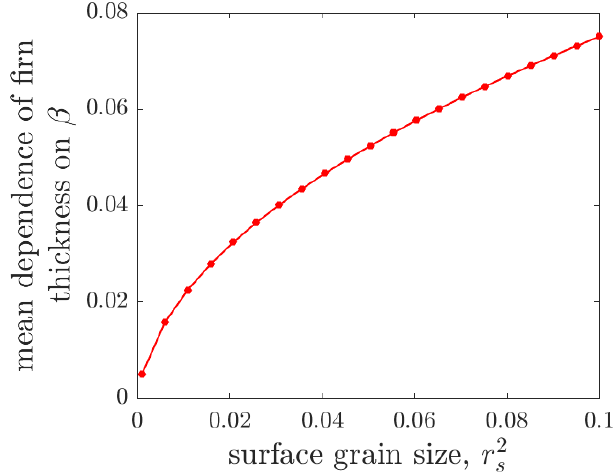
Figure 5. The dependence of firn thickness z 830 on accumulation rate β and how this varies with surface grain size, r 2 s . These values were computed as the gradients of the curves in the insets of Fig. 4 (and from the results of 10 additional simulations), which each used a different value of r 2 s . The gradients were computed using linear least-squares regression. Note that as surface grain size increases, the firn thickness depends more strongly on the accumulation rate. This is the same relationship shown in Fig.